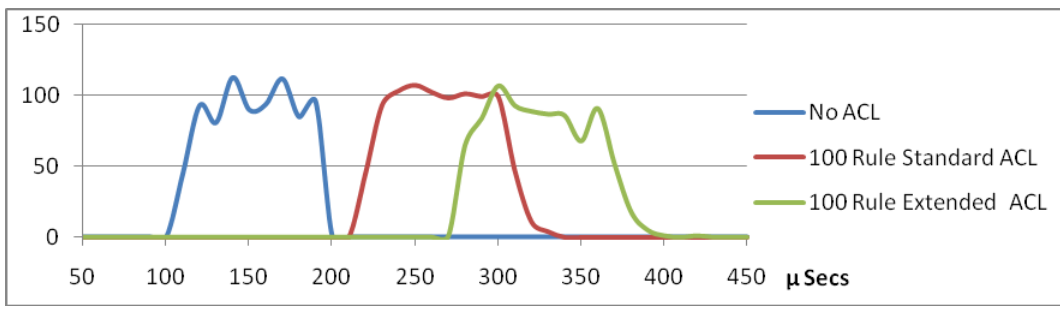
Figure 3. Delay through router with Access Control List (ACL) running Basic OS.